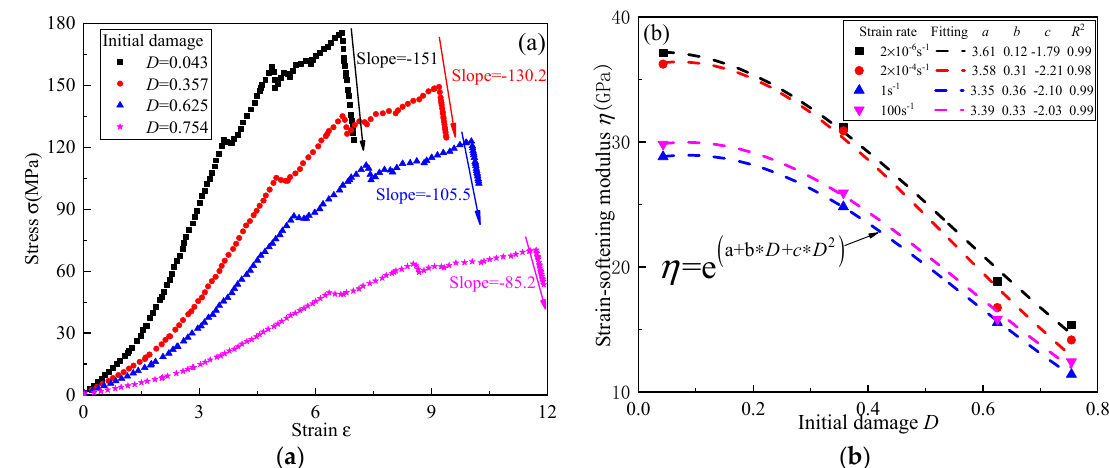
Figure 15. Plot of the strain softening modulus versus the initial damage for limestone from 2 × 10 − 6 s − 1 , 2 × 10 − 4 s − 1 , 1 s − 1 , and 100 s − 1 levels of strain rate: ( a ) σ - ε ; ( b ) η - D.